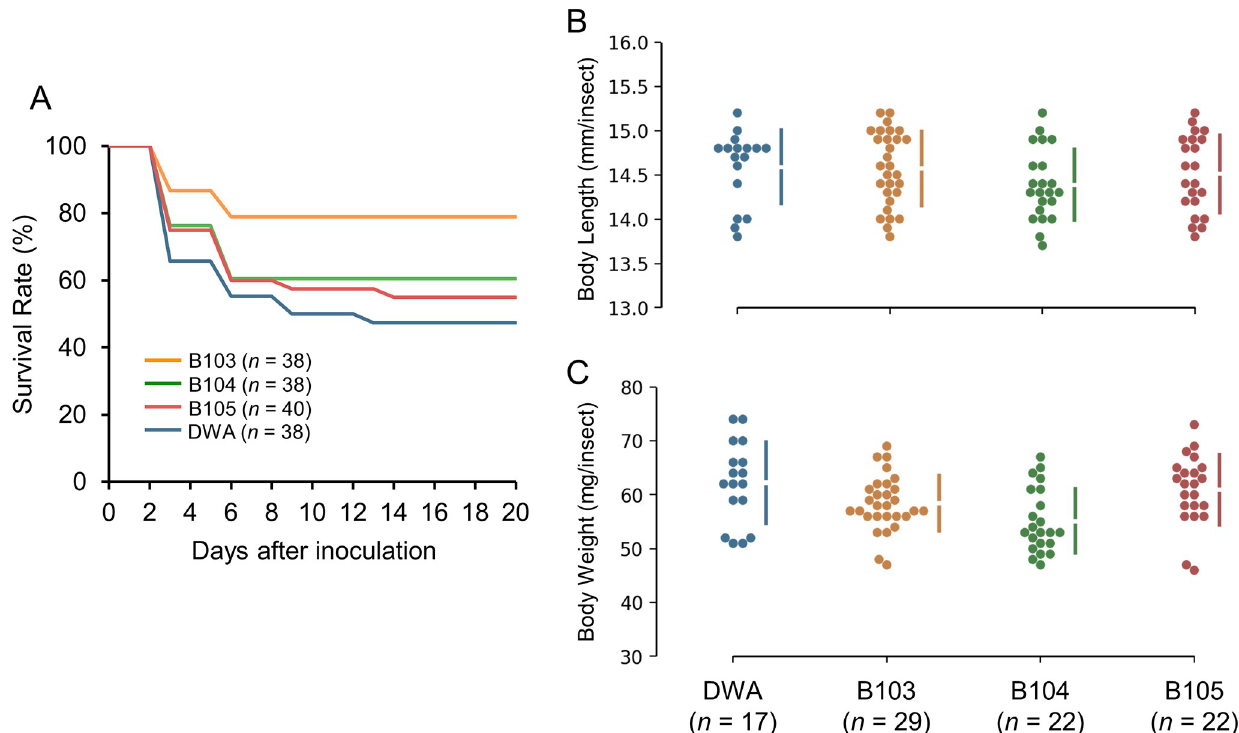
Fig 8. Effects of LAB on host insect development and growth. Improvement in the molt survival rate of bean bugs after feeding of LAB (A). Body length (B) and body weight (C) of adult insects after feeding of LAB. Second-instar nymphs were experimentally inoculated with LAB via feeding. Numbers of insects used in the experiments are indicated in parentheses. This experiment was performed